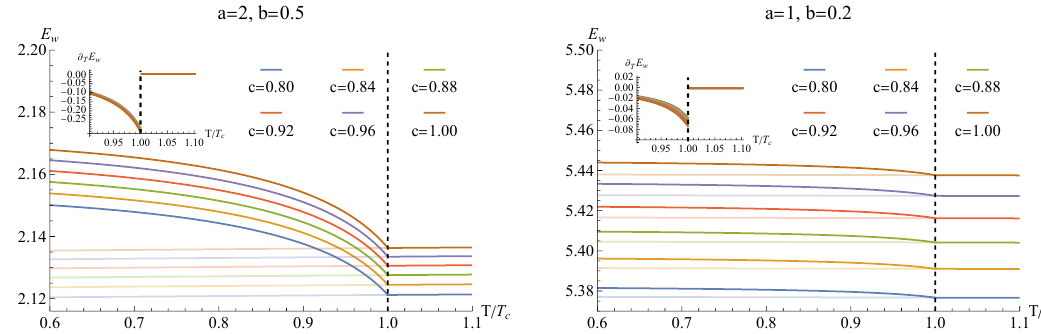
Figure 11 . The EWCS E w vs the temperature T/T c . The inset graph depicts ∂ T E w . The black dashed line depicts the critical temperature. Left plot: the ∂ T E w of the normal phase is greater than zero when a = 2 and b = 0 . 5 . Right plot: the ∂ T E w of the normal phase is less than zero when a = 1 and b = 0 . 2